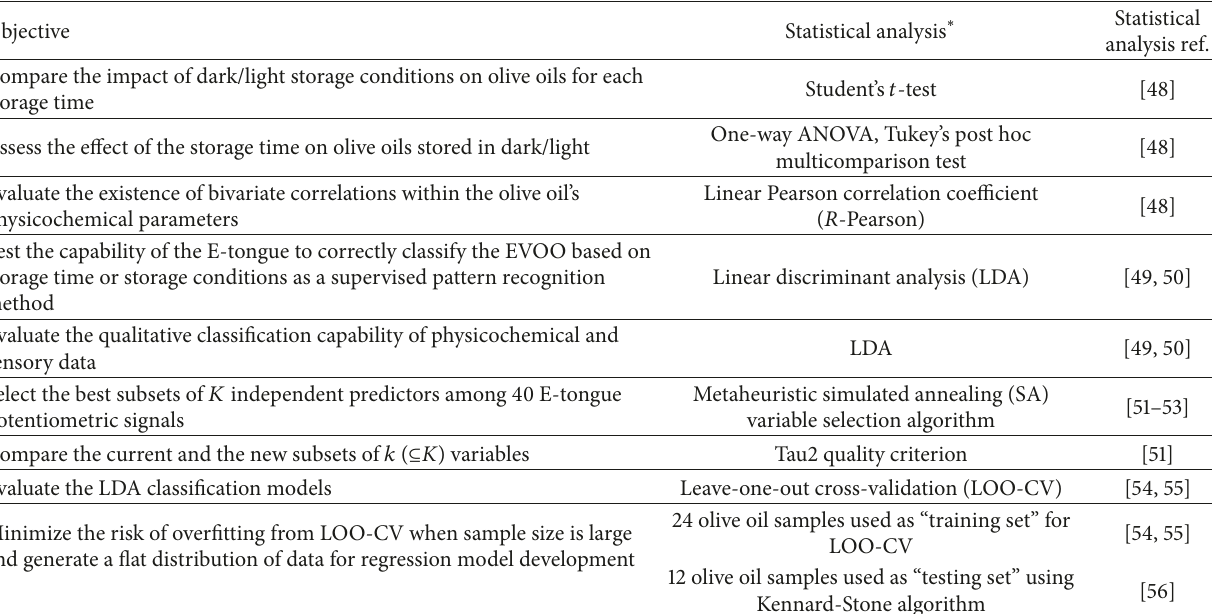
Table 10: Summary of statistical analysis performed by Rodrigues et al.